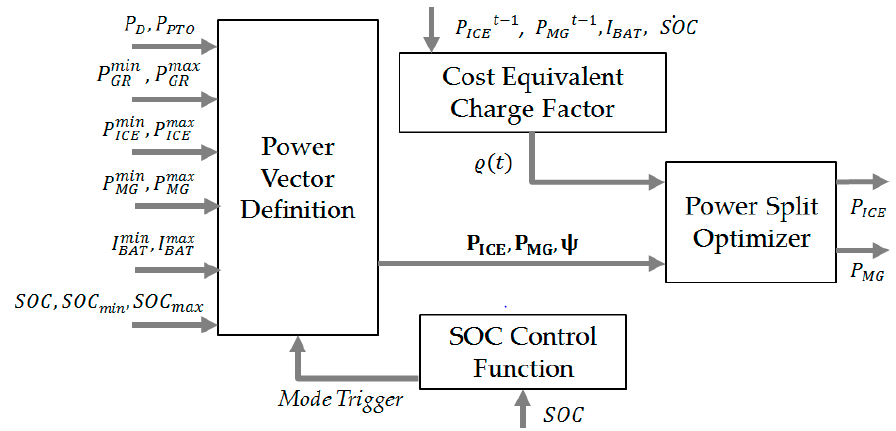
Figure 8. Signal flow scheme of the PMA optimization routine.